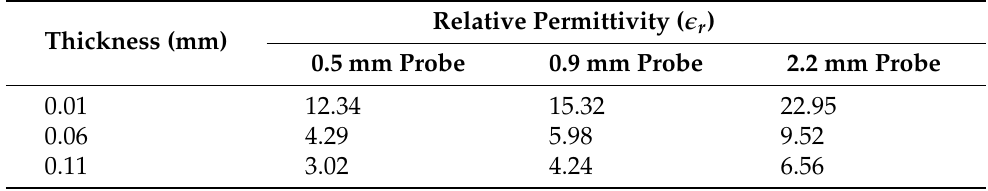
Figure 5. The comparison of skin–olive oil retrieved relative permittivity through simulation of 0.5, 0.9 and 2.2 mm diameter probes as a function of frequency when the second layer thicknesses (d 1 , d 2 and d 3 ) are 0.01, 0.06 and 0.11 mm. Table 10. Three different thicknesses and retrieved relative permittivity of skin–olive oil double- layered configurations at 4 GHz with three